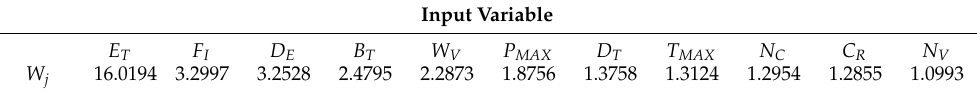
Table 10. Global sensitivity analysis of the MLP 20-10-3 artificial neural network.